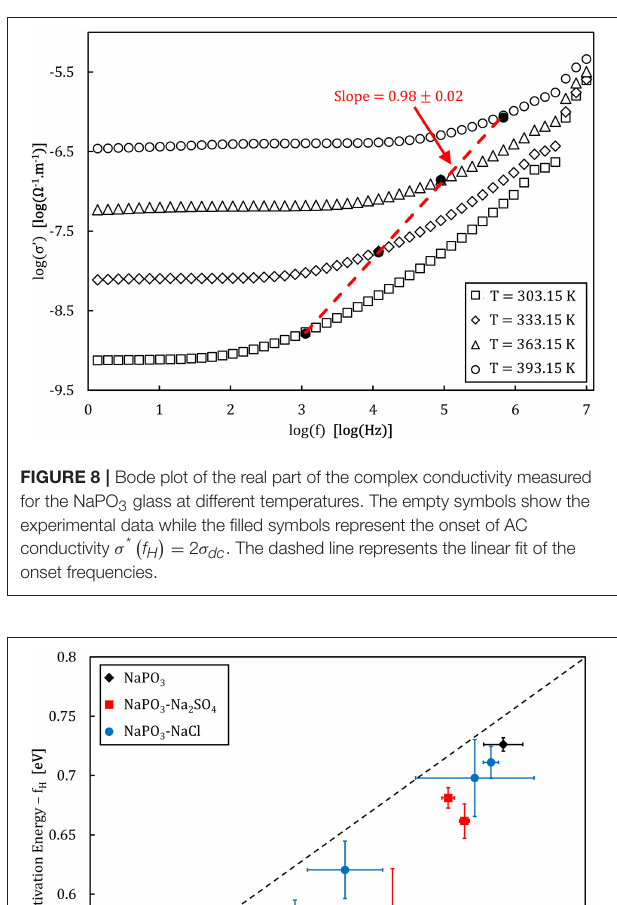
orders of magnitude along the log ( σ dc . T ) axis for each measured frequency, suggesting that the addition of sodium chloride and sodium sulfate enhances the number of effective charge